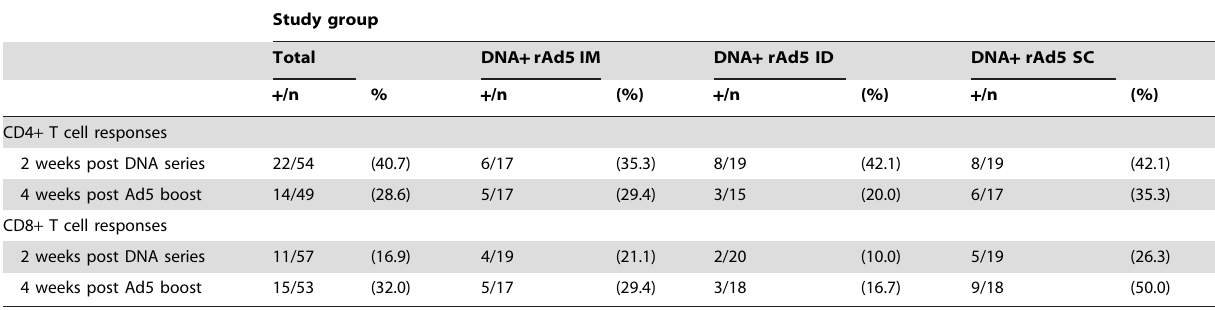
Table 4. ICS responses to any HIV antigen by study visit and study group.